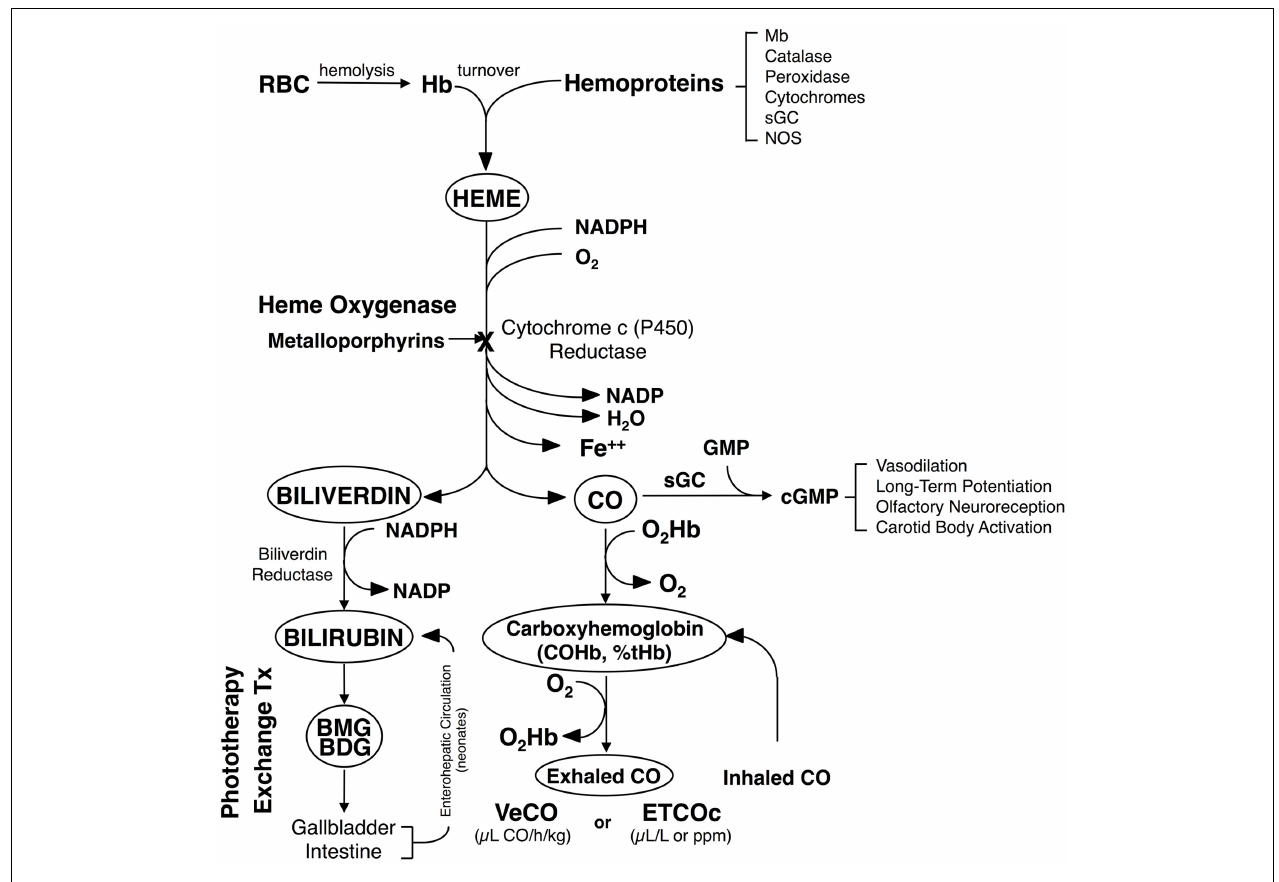
FIGURE 1 | Heme degradation pathway. The turnover of hemoglobin (Hb) and other hemoproteins yields heme.This heme is metabolized to equimolar quantities of carbon monoxide (CO), iron (Fe 2 + ), and biliverdin. Biliverdin is subsequently reduced to form bilirubin. CO is bound to circulating red blood